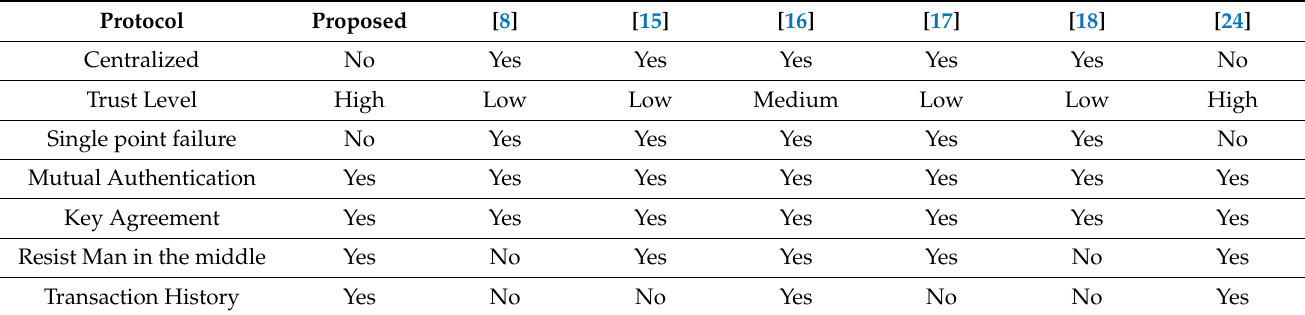
Table 6. Comparison with other